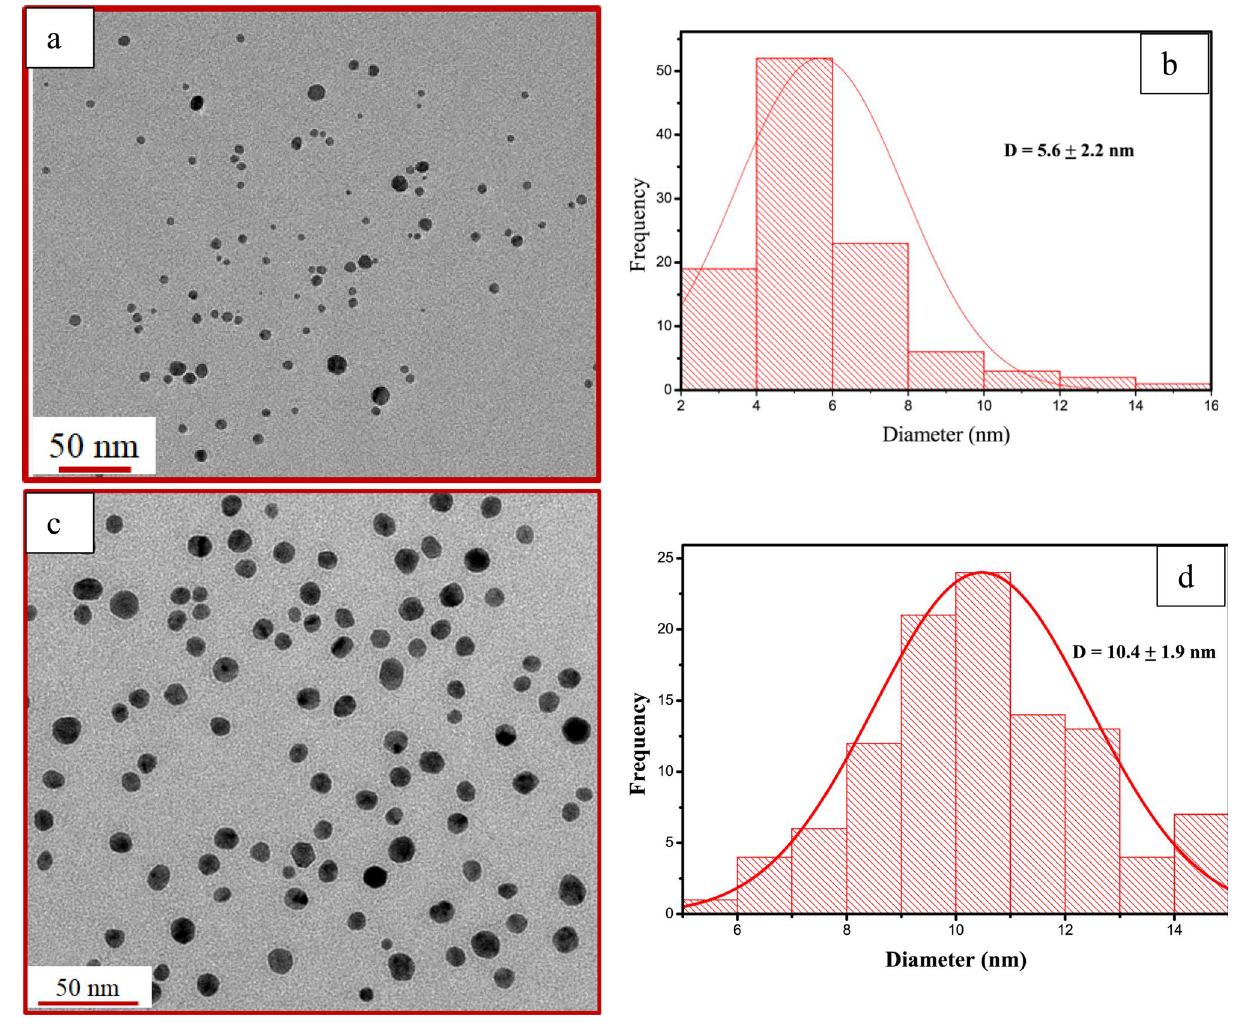
Figure 4. TEM images and corresponding histograms of the AgNPs prepared at pH 9 and 65 °C ( a , b ), and pH 11 and 65 °C ( c , d